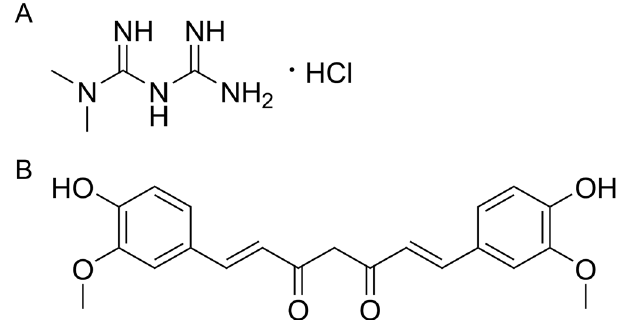
Figure 1. Chemical structures of metformin hydrochloride ( A ) and curcumin ( B